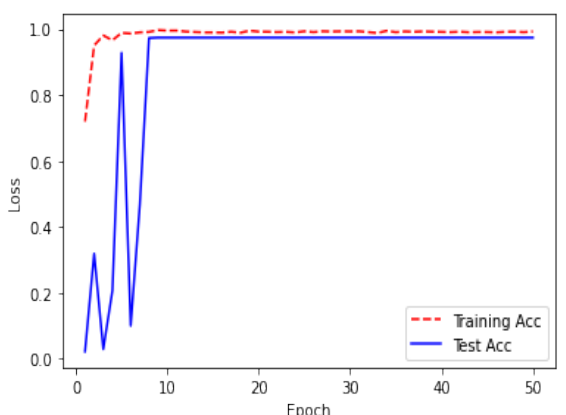
Figure 19. Acc over 50 epochs during the model ResUNet’s training progress for liver segmenta- tion intervals.